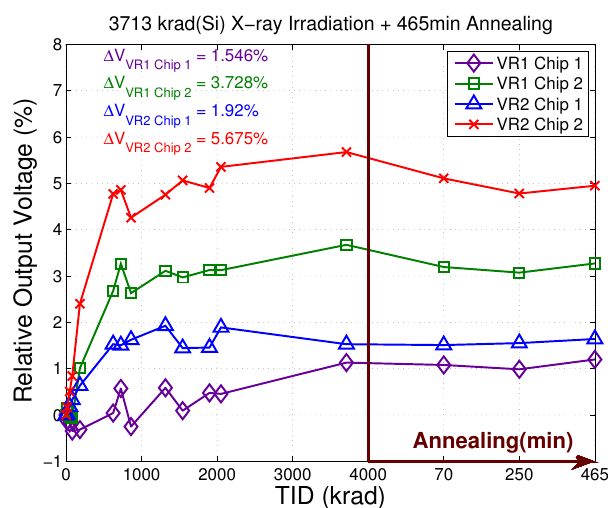
Figure 16. Relative output voltage (%) of the VR1 and VR2 when exposed to X-rays at a dose rate of 8.75 rad(Si)/s.